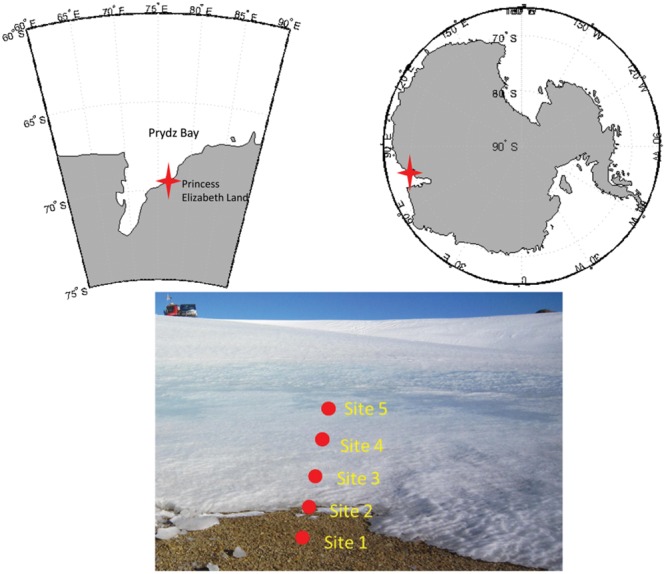
Maps of the study site and the locations of the sampling sites in the glacial foreland. The study site was near the Russian Progress Station at Larsemann Hills on the shore of Prydz Bay. Five sites, including three ice-covered sites, were sampled.